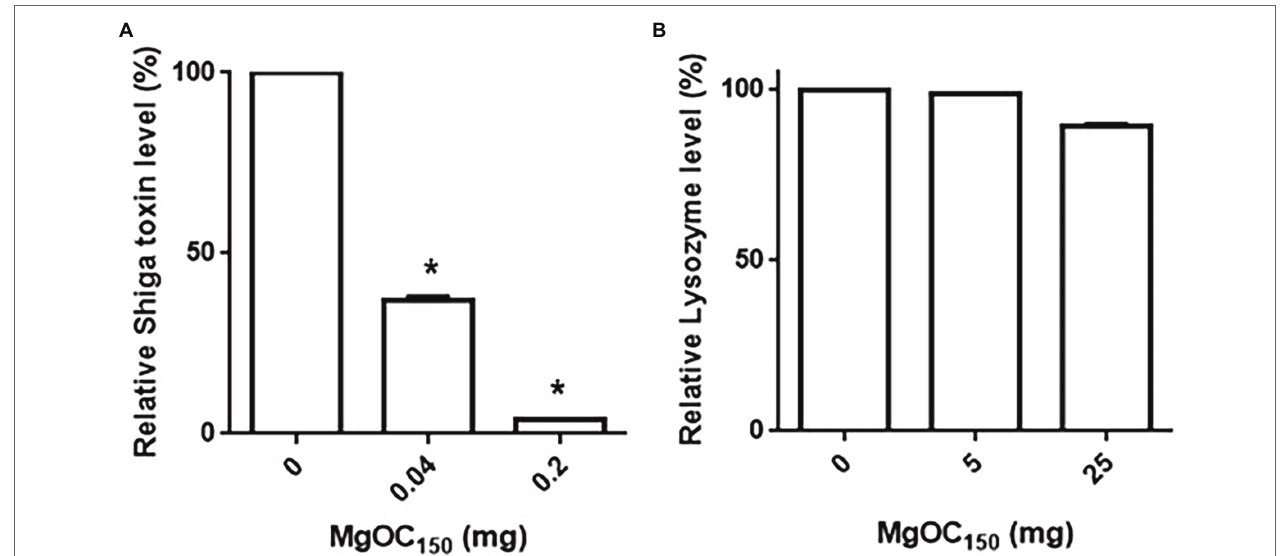
FIGURE 1 | Adsorption of Shiga toxin (A) and lysozyme (B) by MgOC 150 . The Shiga toxin standard (0.4 μ g) or lysozyme (50 μ g) was incubated with and without MgOC 150 , and non-adsorbed proteins were measured in protein assay described in Materials and Methods. Protein levels are presented as the percentage of the value for samples after incubation with MgOC 150 relative to that after incubation without MgOC 150 . Data plotted are the means from three independent experiments; error bars indicate the standard deviations. Asterisks denote significance for values ( p < 0.05) of protein level after incubation with MgOC 150 relative to that after incubation without MgOC 150 .